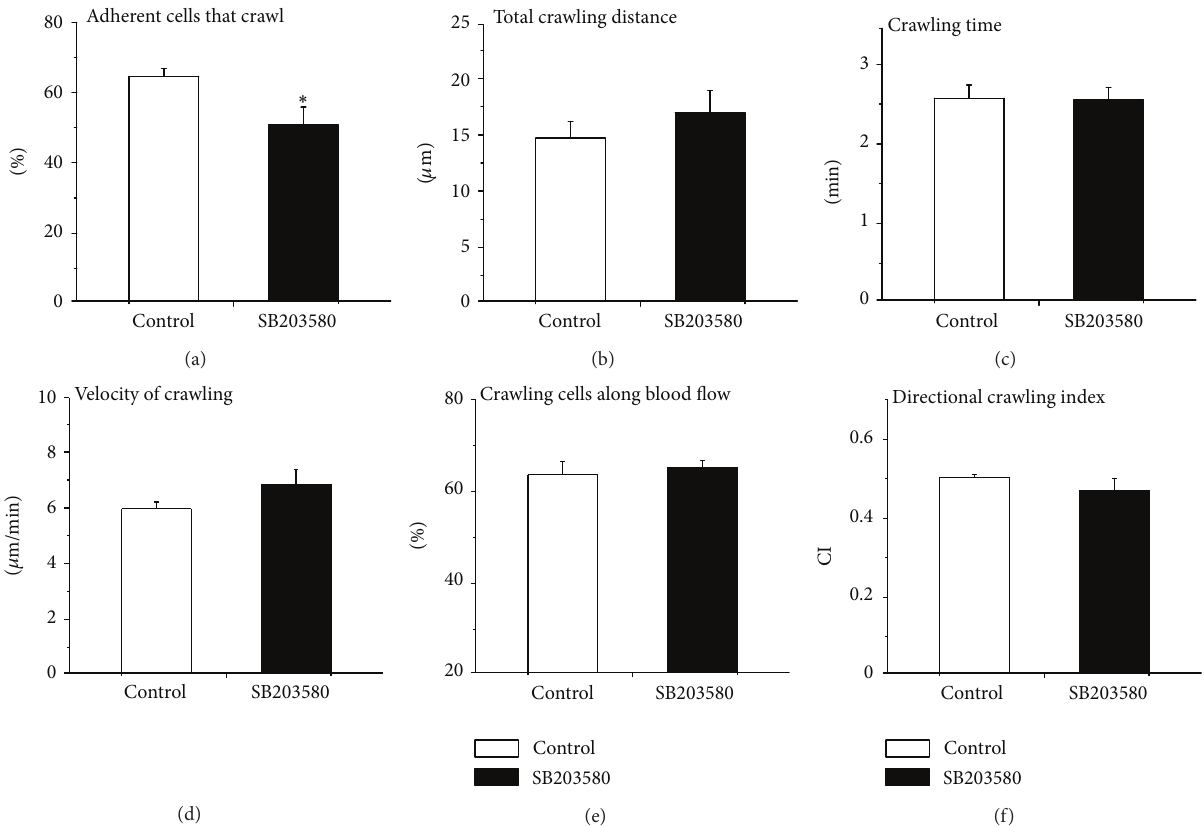
Figure 3: Effect of SB203580 on parameters of KC-induced intraluminal crawling of neutrophils. (a) The percentage of adherent cells that crawl in the luminal surface of the endothelium upon stimulation with KC in the absence (control, white) and in the presence (black) of p38 MAPK inhibitor SB203580 (100nM) 30 min prior to and 60 min following the placement of KC-containing gel. Data are means ± SEM ( 𝑛 = 5 ). ∗ indicates significant difference ( 𝑃 < 0.05 ) from the control without SB203580 ( t -test). (b) The total distance ( 𝜇 m) traversed by a crawling neutrophil (averaged from > 40 cells) in the luminal surface of the endothelium upon stimulation with KC in the absence (Control, white) and in the presence (black) of p38 MAPK inhibitor SB203580 (100nM) 30 min prior to and 60 min following the placement of KC- containing gel. Data are means ± SEM ( 𝑛 = 5 ). (c) The duration (min) of neutrophil crawling in the luminal surface of the endothelium upon stimulation with KC in the absence (control, white) and in the presence (black) of p38 MAPK inhibitor SB203580 (100nM) 30 min prior to and 60 min following the placement of KC-containing gel. Data are means ± SEM ( 𝑛 = 5 ). (d) The velocity ( 𝜇 m/min) of neutrophil crawling in the luminal surface of the endothelium upon stimulation with KC in the absence (control, white) and in the presence (black) of p38 MAPK inhibitor SB203580 (100nM) 30min prior to and 60min following the placement of KC-containing gel. Data are means ± SEM ( 𝑛 = 5 ). (e) The percentage of crawling neutrophils that crawl along the blood flow in the luminal surface of the endothelium upon stimulation with KC in the absence (control, white) and in the presence (black) of p38 MAPK inhibitor SB203580 (100nM) 30 min prior to and 60min following the placement of KC-containing gel. Data are means ± SEM ( 𝑛 = 5 ). (f) The directional crawling index (CI) of neutrophil in the luminal surface of the endothelium upon stimulation with KC in the absence (control, white) and in the presence (black) of p38 MAPK inhibitor SB203580 (100nM) 30min prior to and 60min following the placement of KC-containing gel. Data are means ± SEM ( 𝑛 = 5